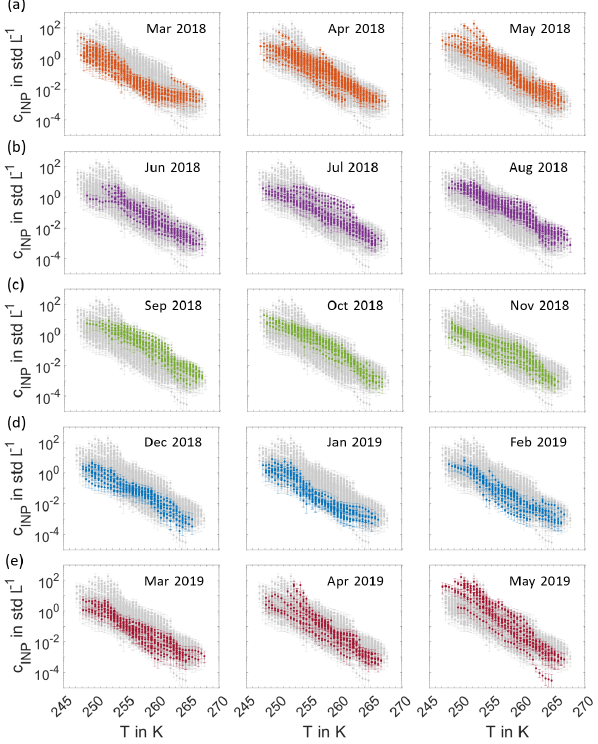
Figure 1. Monthly overview of INP temperature spectra. Each panel shows the entirety of INP temperature spectra measured from 11 March 2018 to 31 May 2019 (grey), with the spectra of the specific month highlighted in